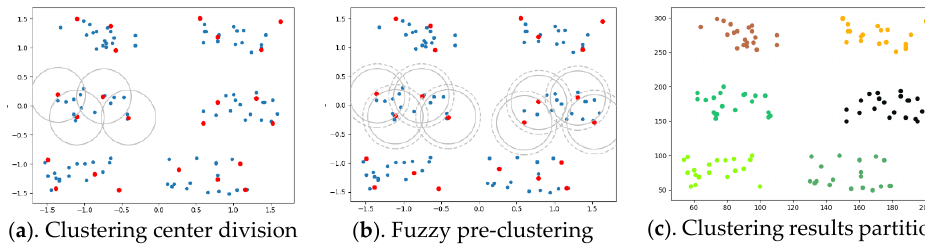
Figure 1. Data sample division process.